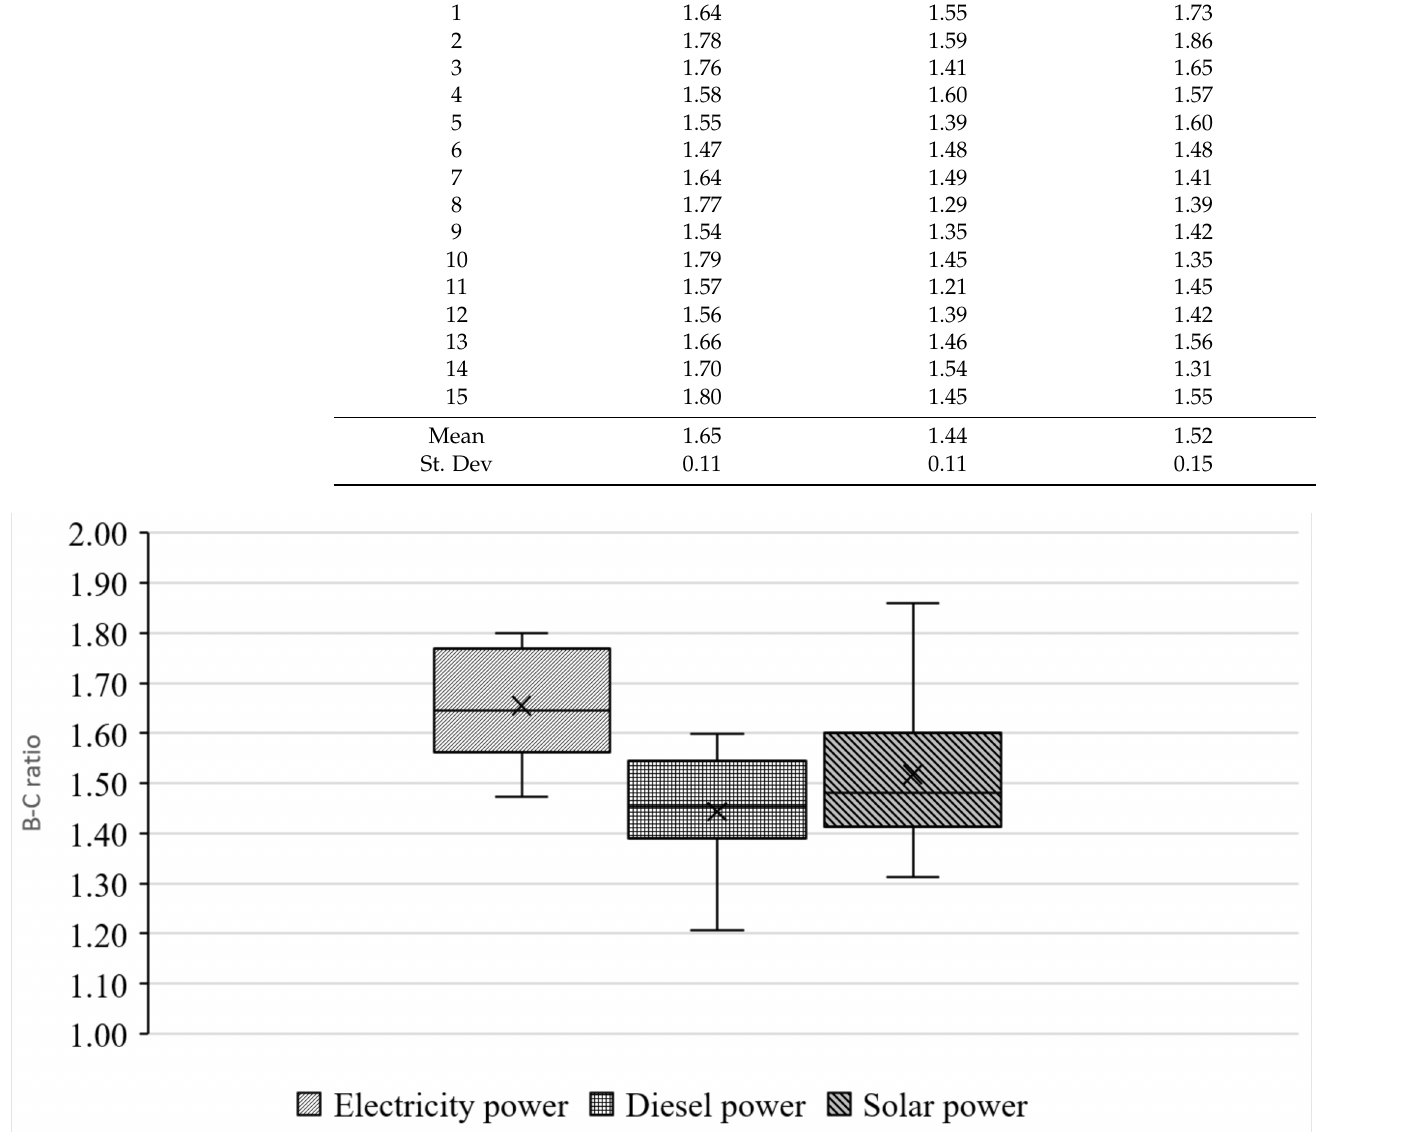
Figure 4. Benefit:cost ratio of different power sources for drip irrigation systems.